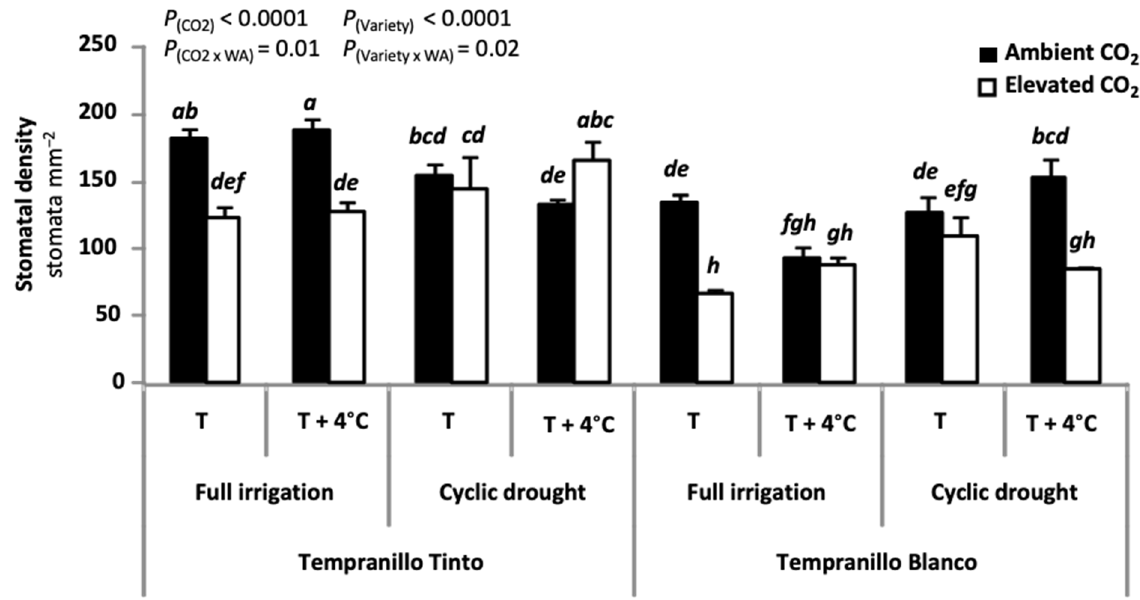
Figure 1. Stomatal density (stomata mm − 2 ) of the leaf abaxial side (stomata were not detected in the adaxial side) at maturity in Tempranillo Blanco and Tinto grapevine. Treatments used for growing the plants were as follows: ambient CO 2 concentration (400 ppm) versus elevated (700 ppm), ambient temperature (T) versus ambient + 4 °C (T + 4 °C), and full irrigation versus cyclic drought. Significant differences ( p < 0.05) were based on LSD test (n = 3, mean ± SE) and are indicated by different letters. See Figure S1 for optical microscope pictures. Data were obtained by T. Kizildeniz during her PhD thesis in leaf surface replicas performed using nail polish as previously described [16] and observed under an optical microscope (NIKON, YS2-H,